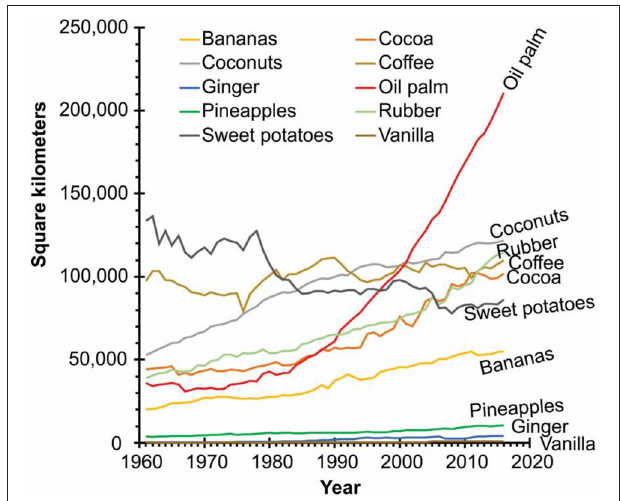
FIGURE 1 | Change over time from 1960 to 2017 in area harvested for different tropical crops ( FAOSTAT, 2019). Note the graph excludes soybean, which is more commonly grown in subtropical or temperate